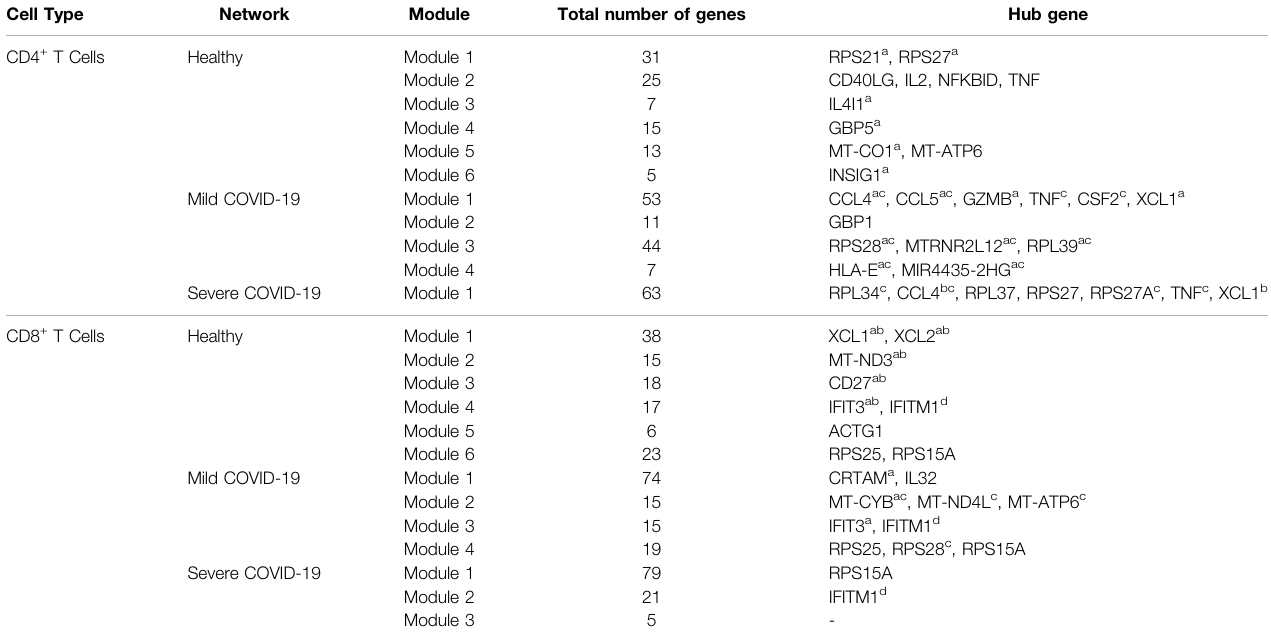
TABLE 2 | Hub genes in each module of each